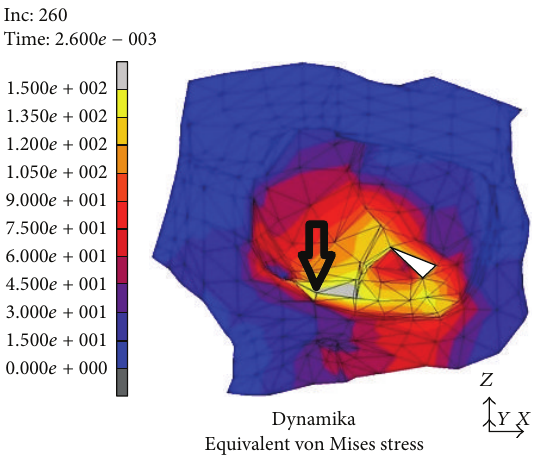
Figure 5: Location of point A in the inferior wall, which served for assessment of the dislocation.